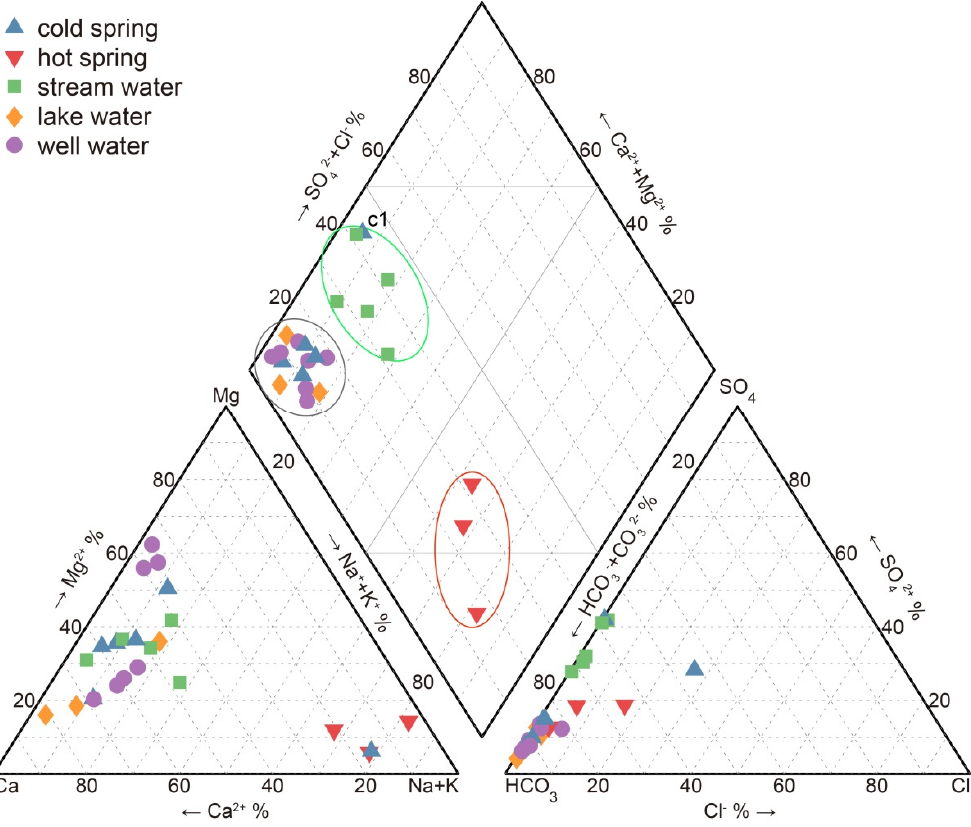
Figure 3. Piper diagram for all water samples.